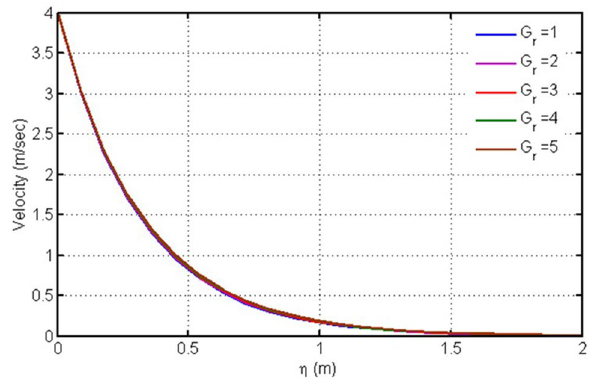
Figure 5. Plot for velocity versus η against Gr .